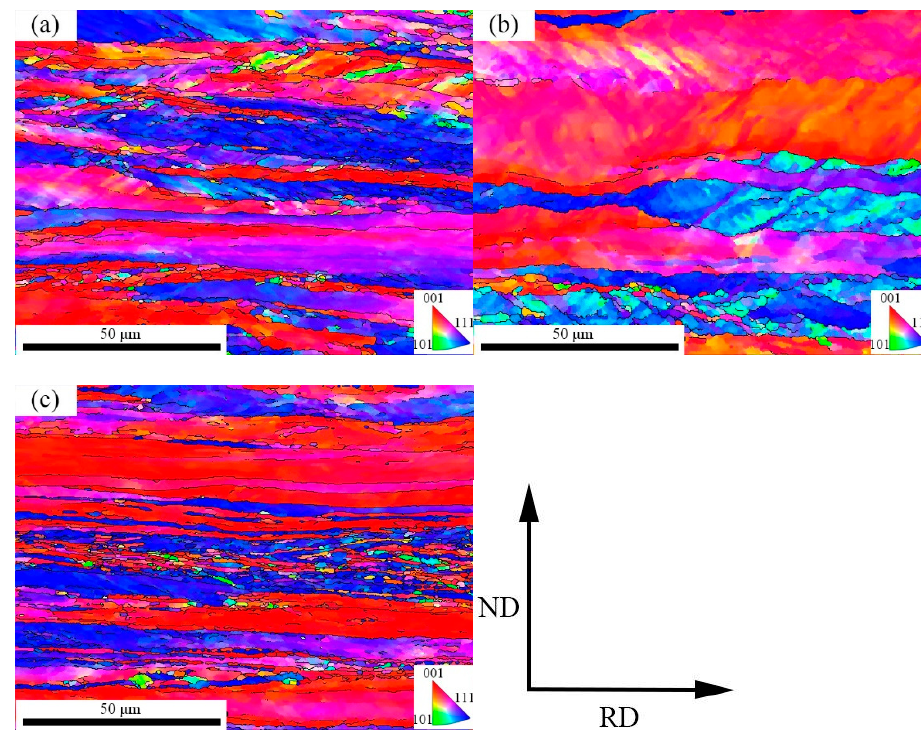
Figure 11. EBSD center IPF orientation maps of samples rolled with different reduction rates ( a ) 800